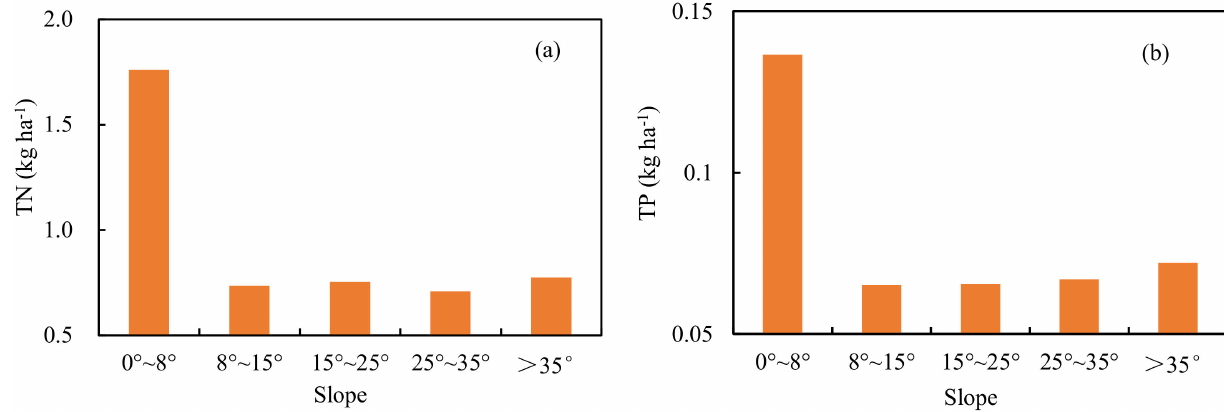
Figure 11. TN ( a ) and TP ( b ) pollution load intensity of different slope in Lake Erhai watershed.